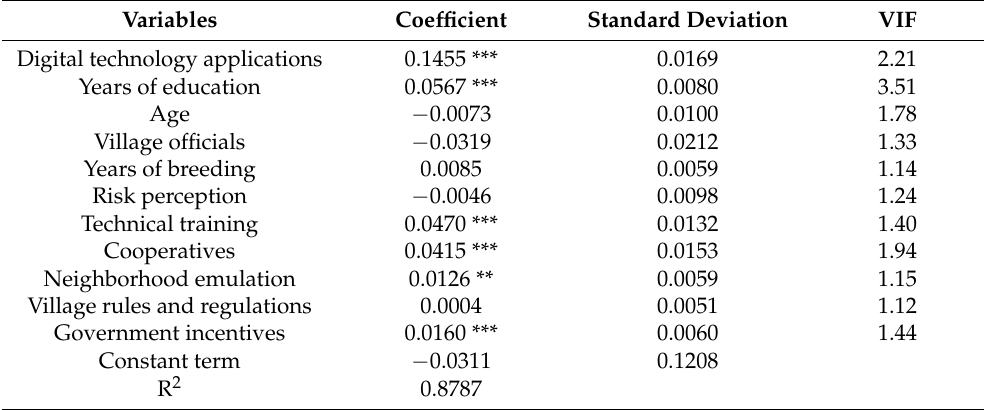
Table 4. The baseline regression results of digital technology application on carbon emission efficiency in dairy